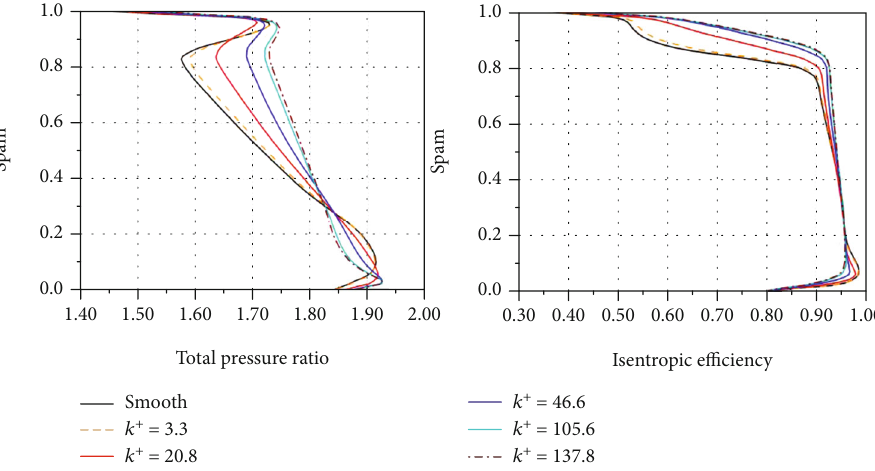
Figure 9: Spanwise variation of performance parameters at the compressor rotor outlet section.